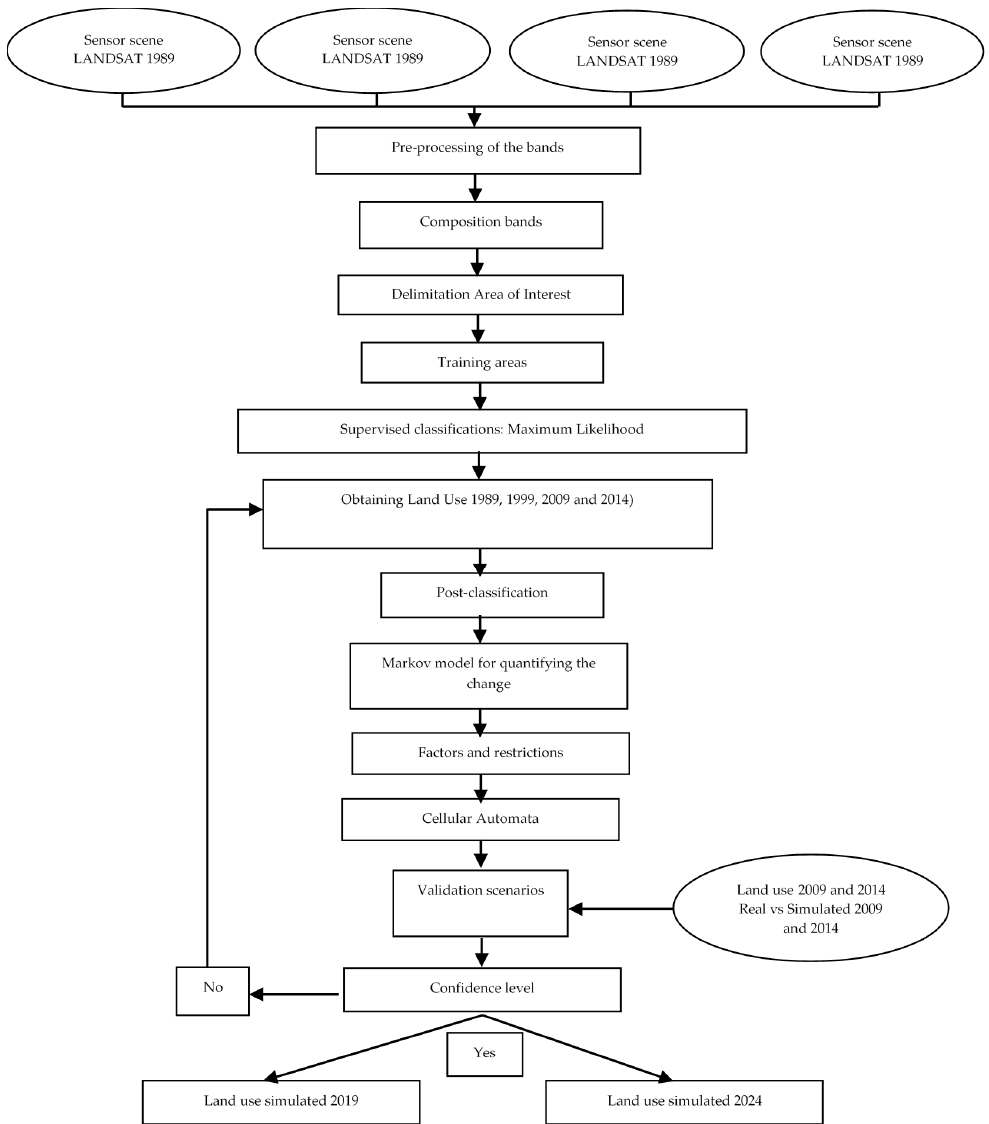
Figure 5. Procedure followed to analyze the spatio-temporal changes of seven land uses in the urban and metropolitan areas of Chihuahua City.